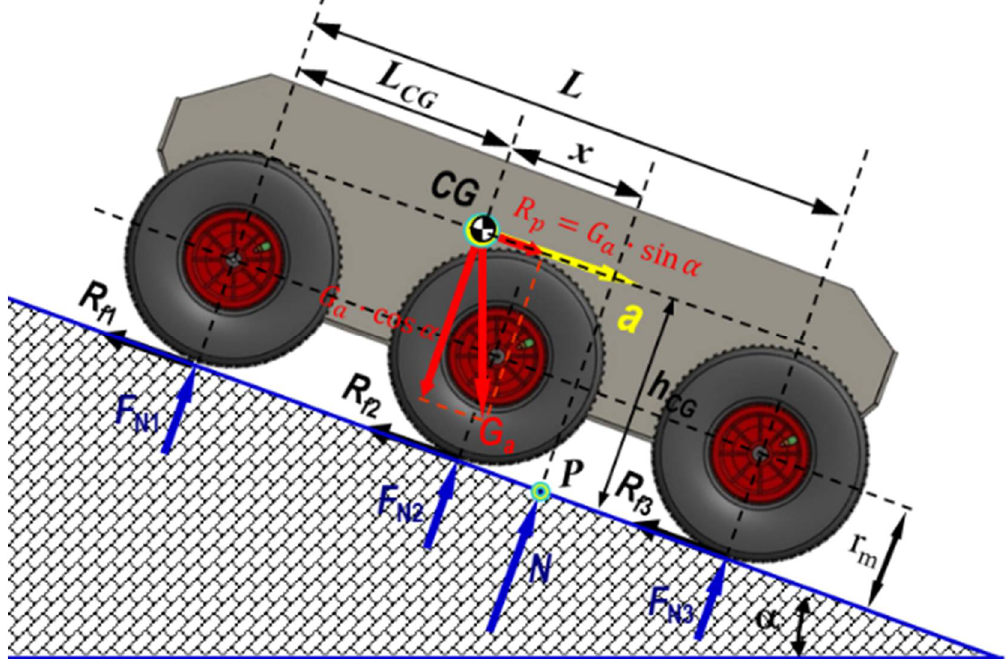
Figure 14. Schematic of braking while descending a longitudinal slope. The dynamics of the robot during braking are much more suggestive when the process is diagrammed during the descent of a slope. In this case, two other notions intervene: a , deceleration when braking; R f , friction force.